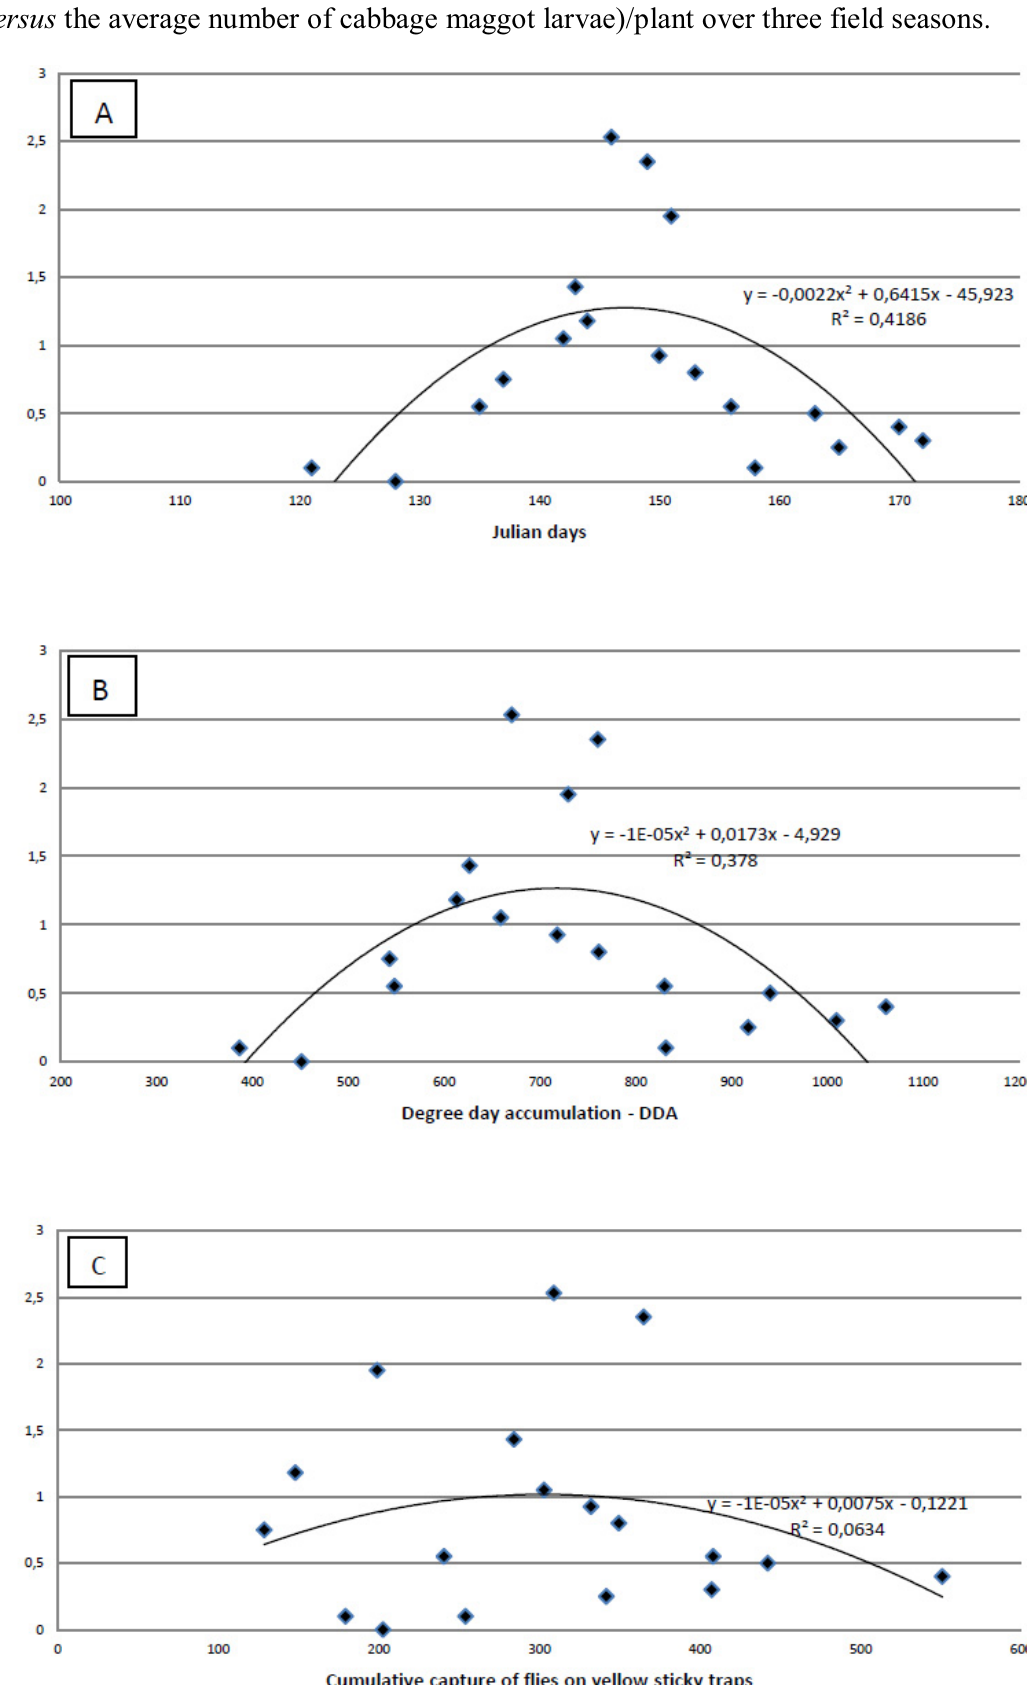
Figure 5. Regression analysis of Julian days ( A ), degree-day accumulation (base threshold 4.3 °C) (cid:178) DDA ( B ) and cumulative capture of cabbage maggot flies on yellow sticky traps (b) versus the average number of cabbage maggot larvae)/plant over three field